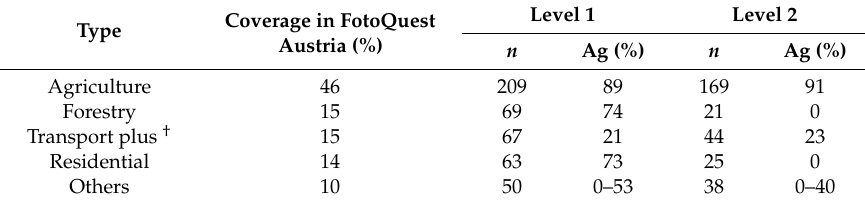
Table 8. Land use main agreement (Ag) areas (sorted by percentage covered in FotoQuest Austria) between the two systems. Number of observations ( n ) is